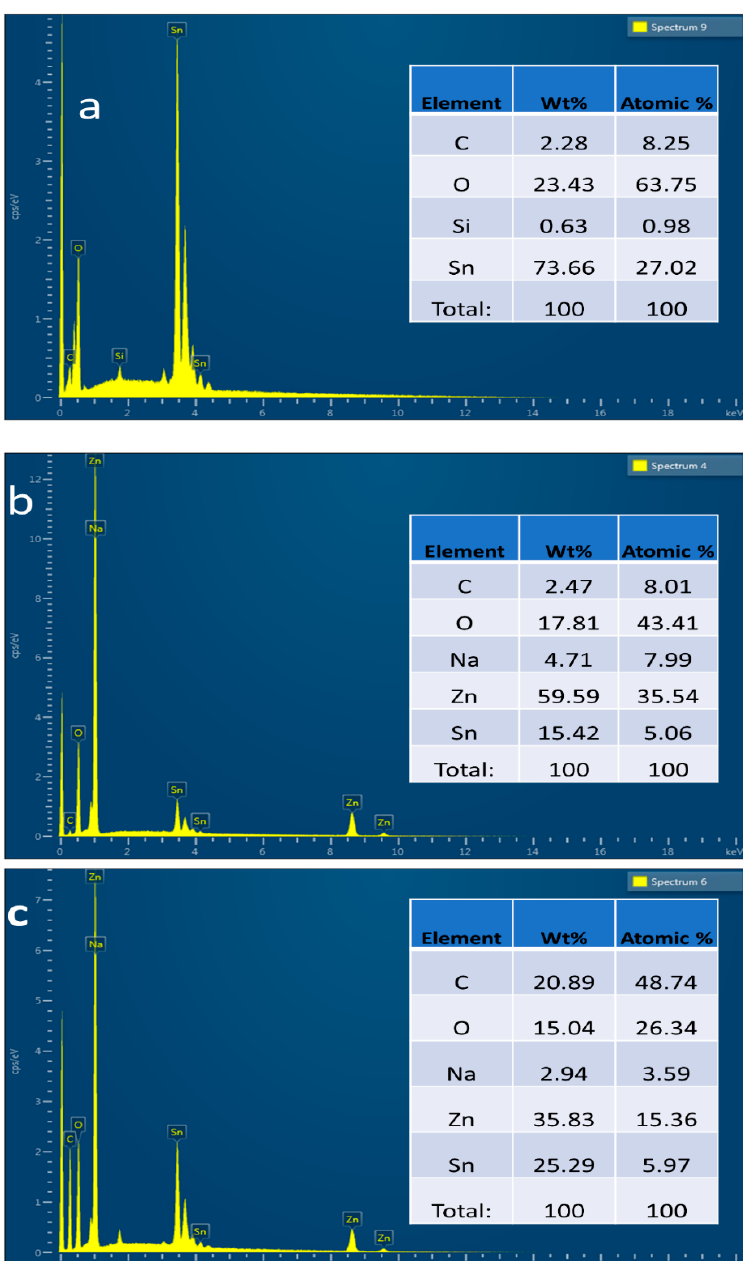
Figure 5. EDS analysis of, ( a ) EDS spectrum of fluorine tin oxide (FTO) glass (that was used as a substrate); ( b ) EDS spectrum of ZnO thin film; ( c ) GrF/ZnO composite.